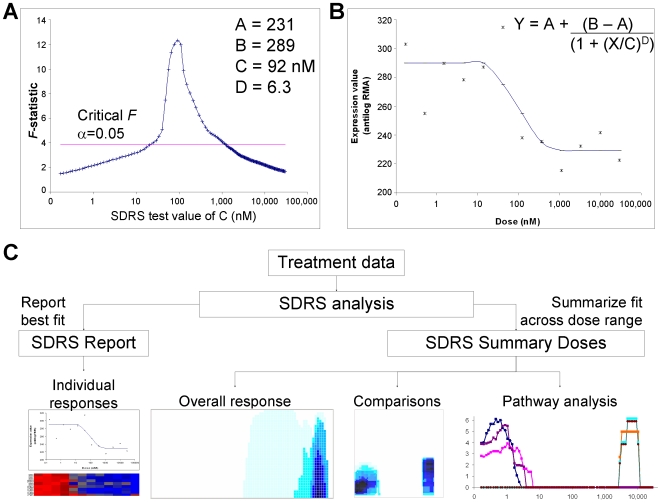
Implementation and output of SDRS algorithm.(A) SDRS analysis of intensity data for probeset 205016_at (Transforming Growth Factor Alpha), following a four hour treatment with dasatinib. The plot shows the maximal F-statistic obtained for this probeset at each C value evaluated by SDRS. The critical value of the F-distribution at P<0.05 is indicated. The global maximal F was obtained from fit of experimental data to a sigmoidal dose response model with the values of A, B, C, D shown. (B) The experimental data for probeset 205016_at, and the curve obtained using the optimal model parameters established by SDRS in the equation shown. (C) Schematic diagram of the data analysis flow. The SDRS report (left) contains the calculated pharmacological parameters for each probeset, and can be used to identify individual response transcript of interest. This report is qualitatively similar to the output of an iterative algorithm. The SDRS Summary Doses output (right) is unique to the grid search method. This dataset is used for the further approaches shown, which characterize and compare the overall transcriptional responses. A more detailed flowchart of SDRS is provided in Text S1.